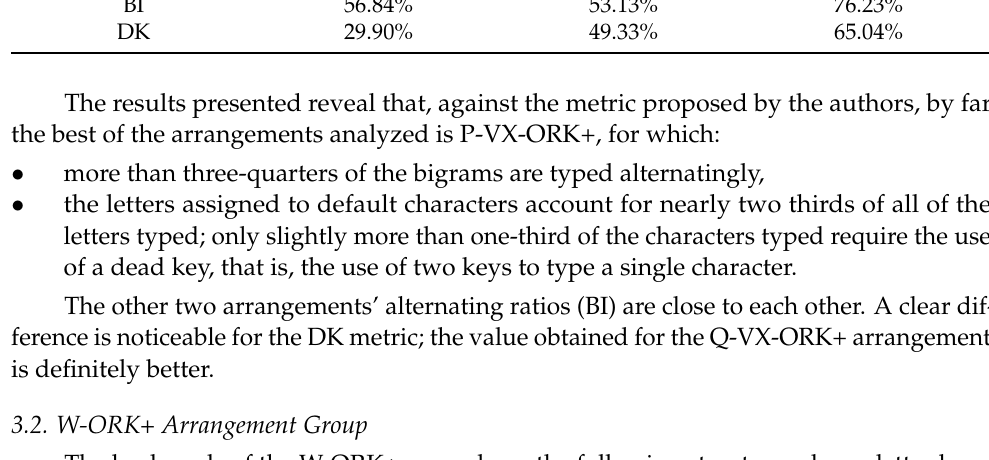
Table 1. Assessment of VX-ORK+ group arrangements.